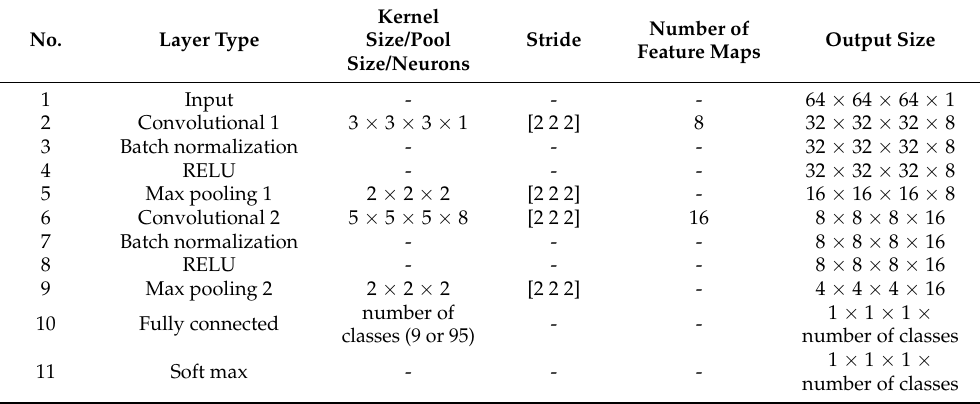
Table A1. Architecture of the CNN